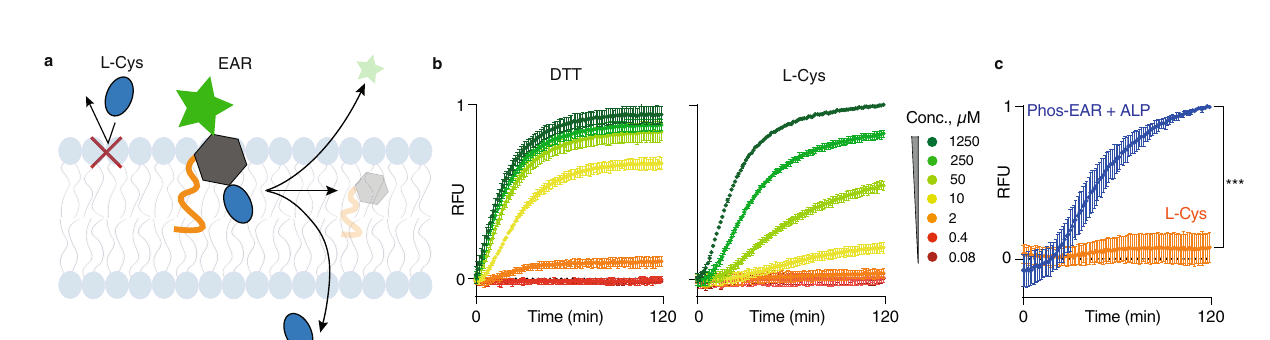
phosphatase (ALP), β -glucosidase (GLU), or β -glucuronidase (GUS). b The data are expressed relative to the max value of the EAR+enzyme sample in Phos-EAR and Gus-EAR, respectively, the Glu-EAR samples are relative to the Gus-EAR+GUS. b The data are based on three replicates with triplicates ( N =3, n =3) presented as mean±SD. RFU=relative fl uorescence expressed in arbitrary units; statistical sig- ni fi cance at endpoint was calculated via an unpaired two-tailed t test, *** P <0.001, ** P <0.01 (95% con fi dence interval). Source data are provided as the Source Data fi